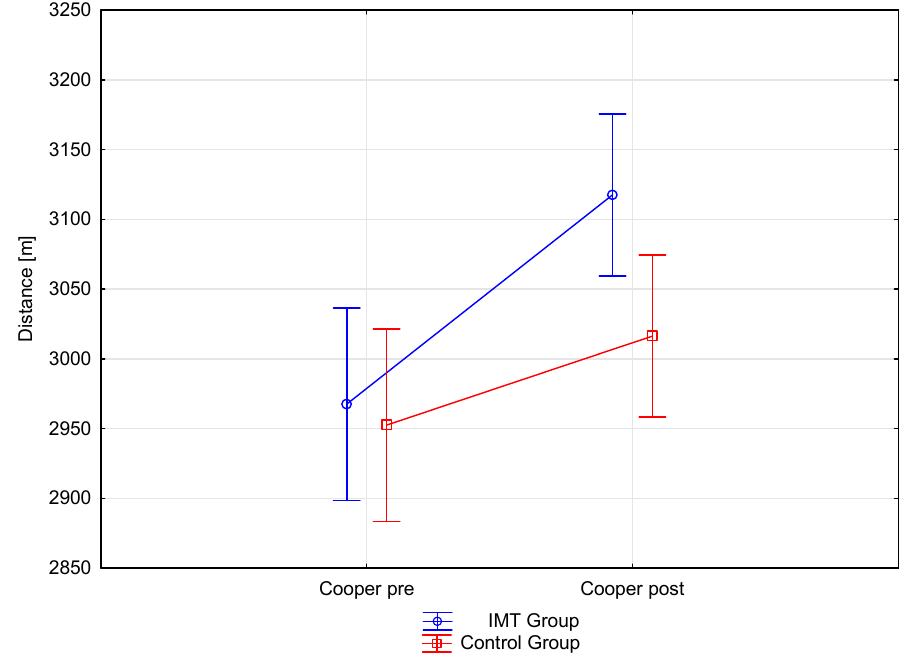
Figure 2. Mean Cooper test measurement pre- and post-inspiratory muscle training (IMT) and endurance training. Vertical bars represent the confidence interval of 0.95.